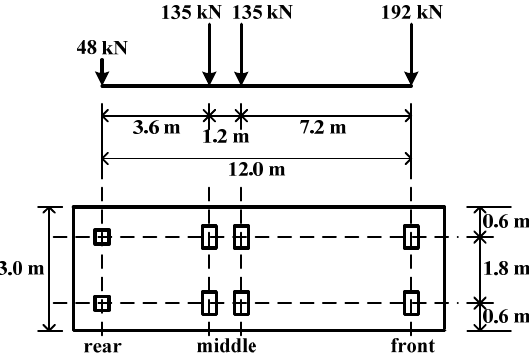
Figure 5. Characteristics of the design truck.